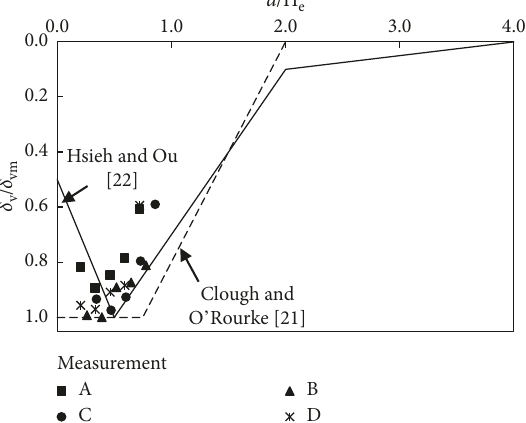
Figure 12: Relationship between δ